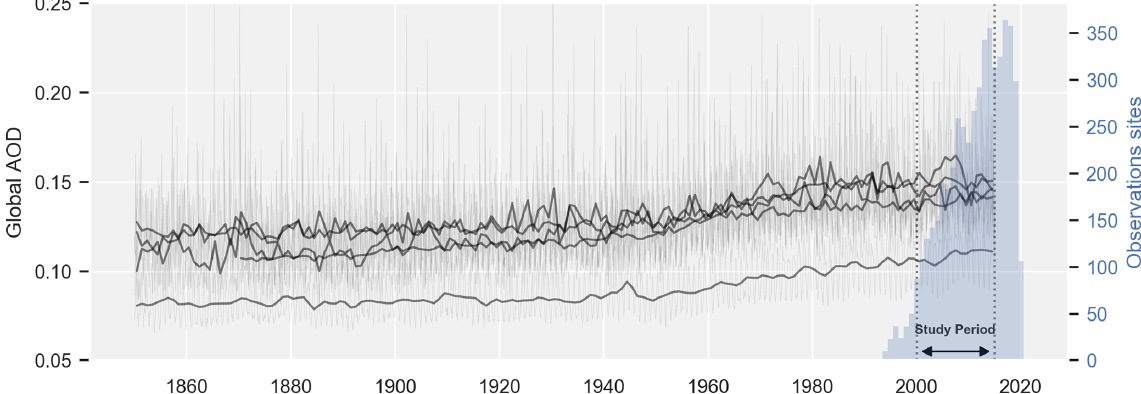
Figure 1. Global AOD computed from model historical runs (Oslo CTM3, GFDL-AM4, CanESM5, CESM2, IPSL-CM6A, ECHAM-HAM) at monthly (gray lines) and yearly (black lines) resolutions, overlaid with the number of active observation sites in the AERONET sun photometer network. Table 1. List of observations and model datasets used in this study (see text for explanation).